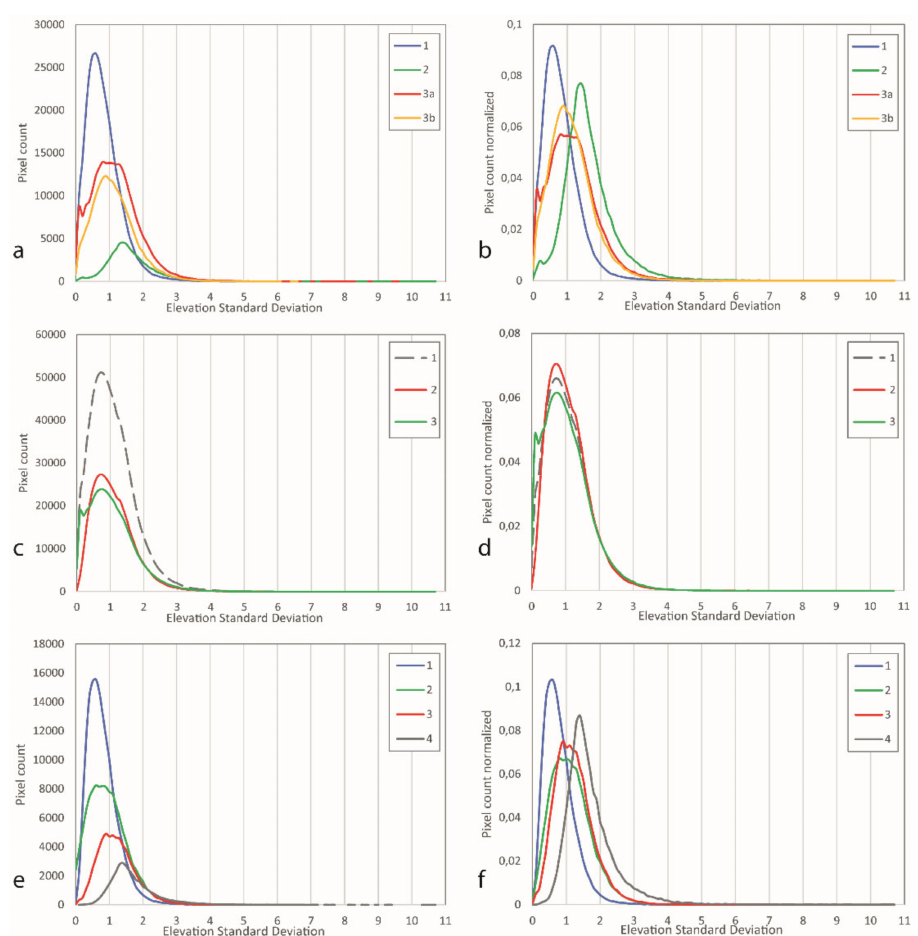
Figure 7. Trends of ESD variable: ( a ) in the sectors subdividing the study area: Pesaro–Punta degli Schiavi (1), Punta degli Schiavi–Mt. Brisighella (2), Mt. Brisighella–Castel di Mezzo (3a), and Castel di Mezzo–Vallugola (3b); ( b ) in the sectors subdividing the study area considering normalized values: Pesaro–Punta degli Schiavi (1), Punta degli Schiavi–Mt. Brisighella (2), Mt. Brisighella–Castel di Mezzo (3a), and Castel di Mezzo–Vallugola (3b); ( c ) in the total study area (1) in comparison with areas affected (2) or not affected (3) by landslides; ( d ) in the total study area (1) in comparison with areas affected (2) or not affected (3) by landslides considering normalized values; ( e ) for each landslide typology occurring in the study area: slides (1), slumps (2), flows (3), and diffuse instability (4); ( f ) for each landslide typology occurring in the study area considering normalized values: slides (1), slumps (2), flows (3), and diffuse instability